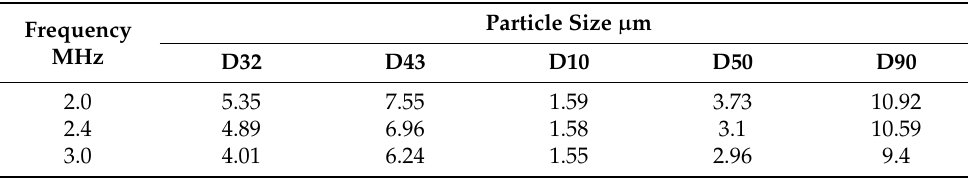
Table 2. Results of particle size.